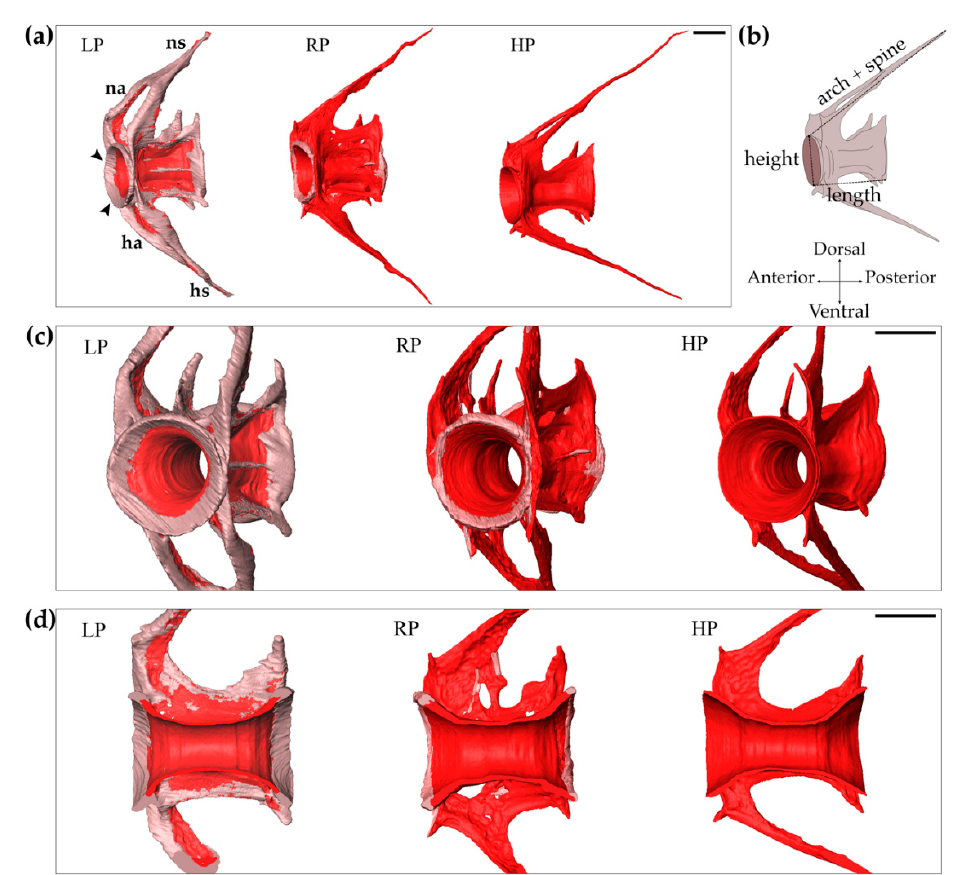
Figure 5. Increased bone formation in LP zebrafish after two months of dietary treatment. Synchrotron X-ray tomographic microscopy scans reveal an increased amount of non-mineralised matrix in the vertebral body and arches of low P diet (LP) treated animals compared to controls (RP) and high P diet (HP) treated individuals. ( a ) Lateral view of the 10th caudal vertebral body, neural (na) and haemal (ha) arches and their spines (ns, hs, respectively). Vertebral endplates are indicated by black arrowheads. Scale bar: 100 µ m. ( b ) Schematic representation of the measured parameters: vertebral body length, vertebral body height, length of arch plus spine. ( c ) Frontal view of vertebrae. Scale bar: 100 µ m. ( d ) Virtual sagittal sections of the vertebral bodies. Scale bar: 100 µ m. Non-mineralised bone: pink; mineralised bone: red.